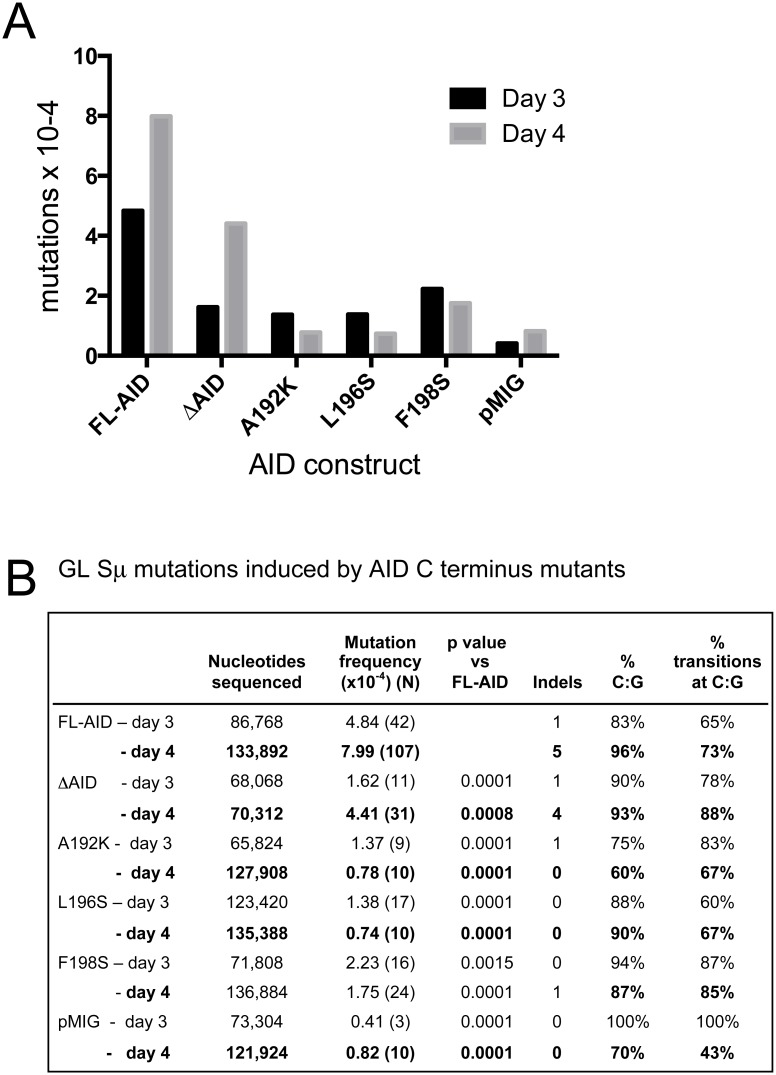
GL 5’Sμ mutations are greatly decreased in aid
-/- cells induced to switch to IgG3 and expressing AID C terminus mutations.A: Frequency of GL 5’Sμ mutations induced by AID mutants expressed in activated aid
-/- cells for 3 and 4 days. B: Frequencies and numbers of nucleotide substitutions, p values, indels, % of mutations occurring at C:G bp, % transition mutations at C:G bp, and numbers of nucleotides analyzed within the GL 5’Sμ mutations induced by the AID mutants.